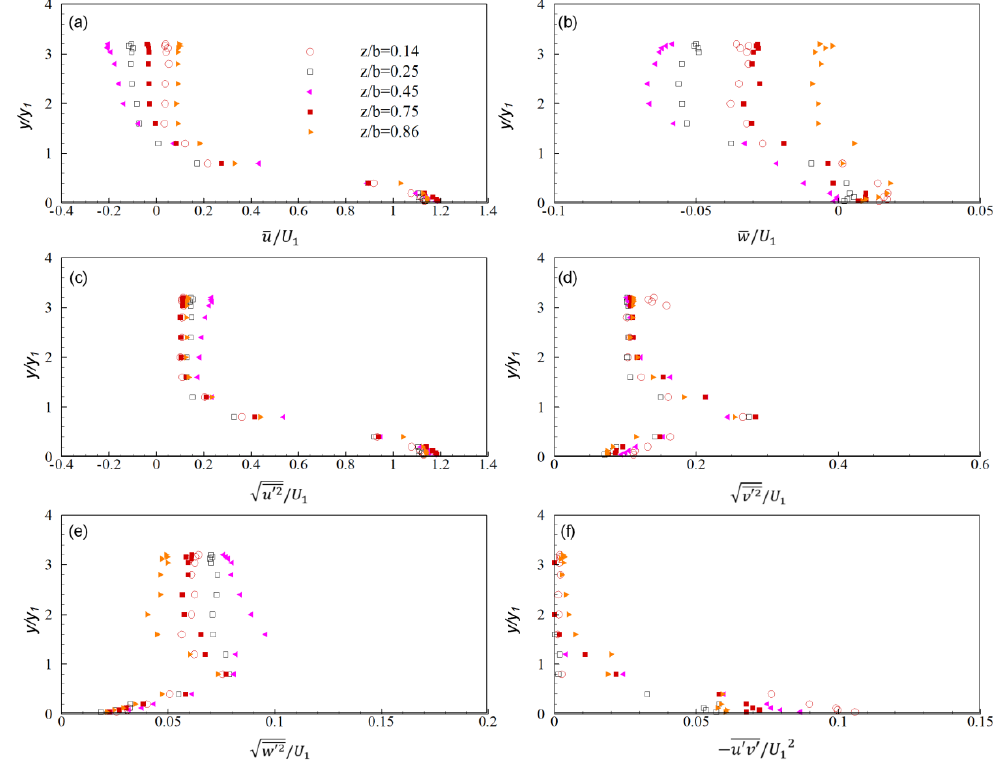
Figure 3. Vertical distributions of dimensionless mean velocity components and Reynolds stresses at x/y 1 = 5. Velocity components are compared in ( a ) and ( b ); Reynolds stresses are compared in ( c ), ( d ), ( e ), and ( f ).